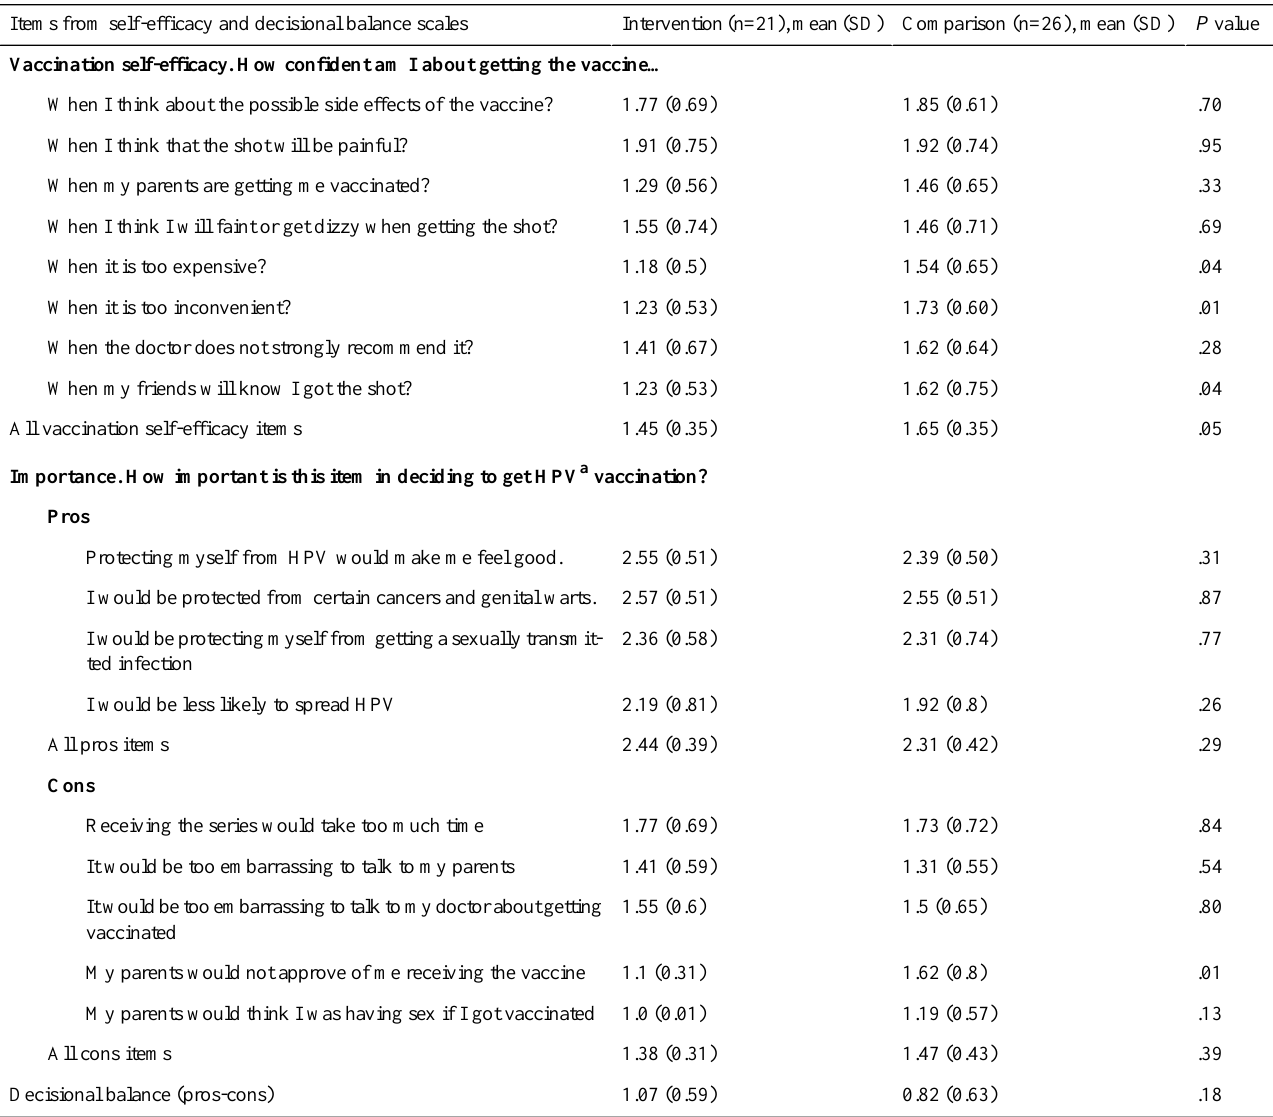
P valueComparison (n=26), mean (SD)Intervention (n=21), mean (SD)Items from self-efficacy and decisional balance scales